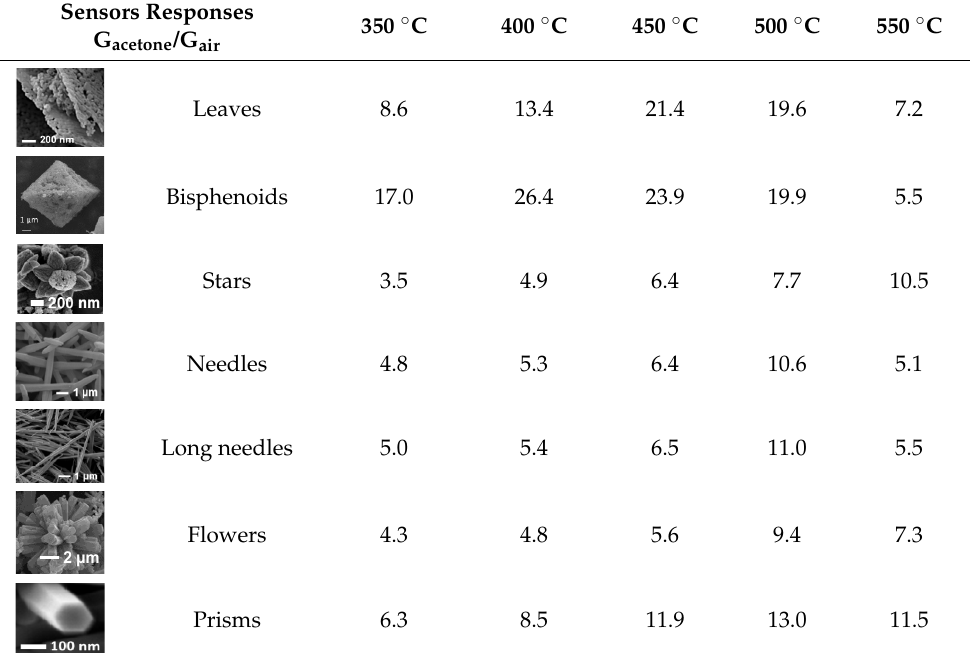
Table 2. Values of sensors responses toward acetone (10 ppm, dry air) as a function of the sensors operating temperature.